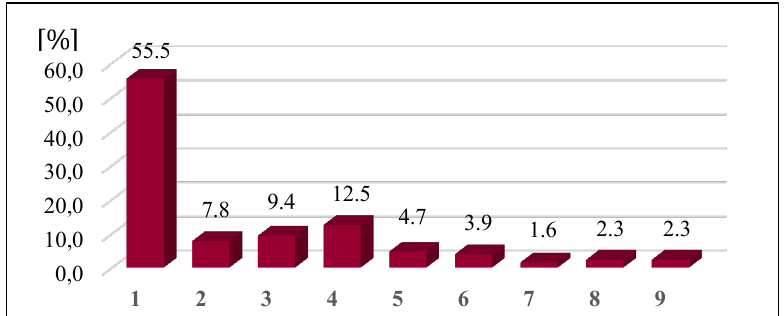
Fig. 7. Results in answers to the item no. 7: „Do you remember which environmental issues you learnt at the lessons of Technical